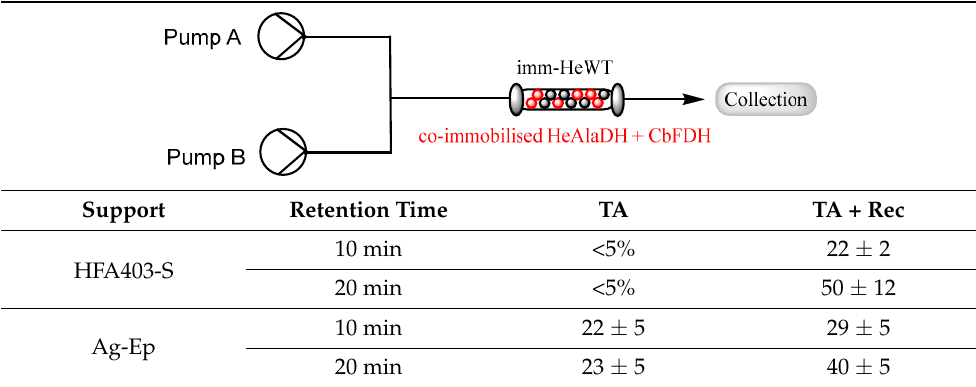
Table 1. Molar conversion of vanillin using a packed bed reactor. Pump A reservoir contained 20 mM vanillin in phosphate buffer pH8 with 20% ( v / v ) DMSO. Pump B reservoir contained 20 mM L-alanine, 200 mM ammonium formate, 2 mM NAD + and 50 mM phosphate buffer pH8. The reaction